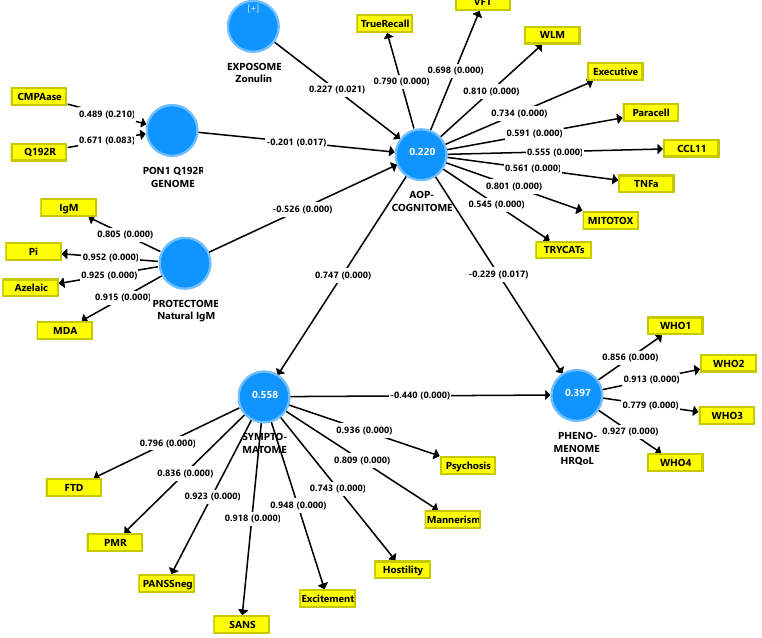
Figure 3. The second Partial Least Squares (PLS) path model constructed in this study. PON1 Q192R: paraoxonase 1 (PON1) genotypes with PON1 4 (chloromethyl) phenyl acetate (CMPA) ase activity.